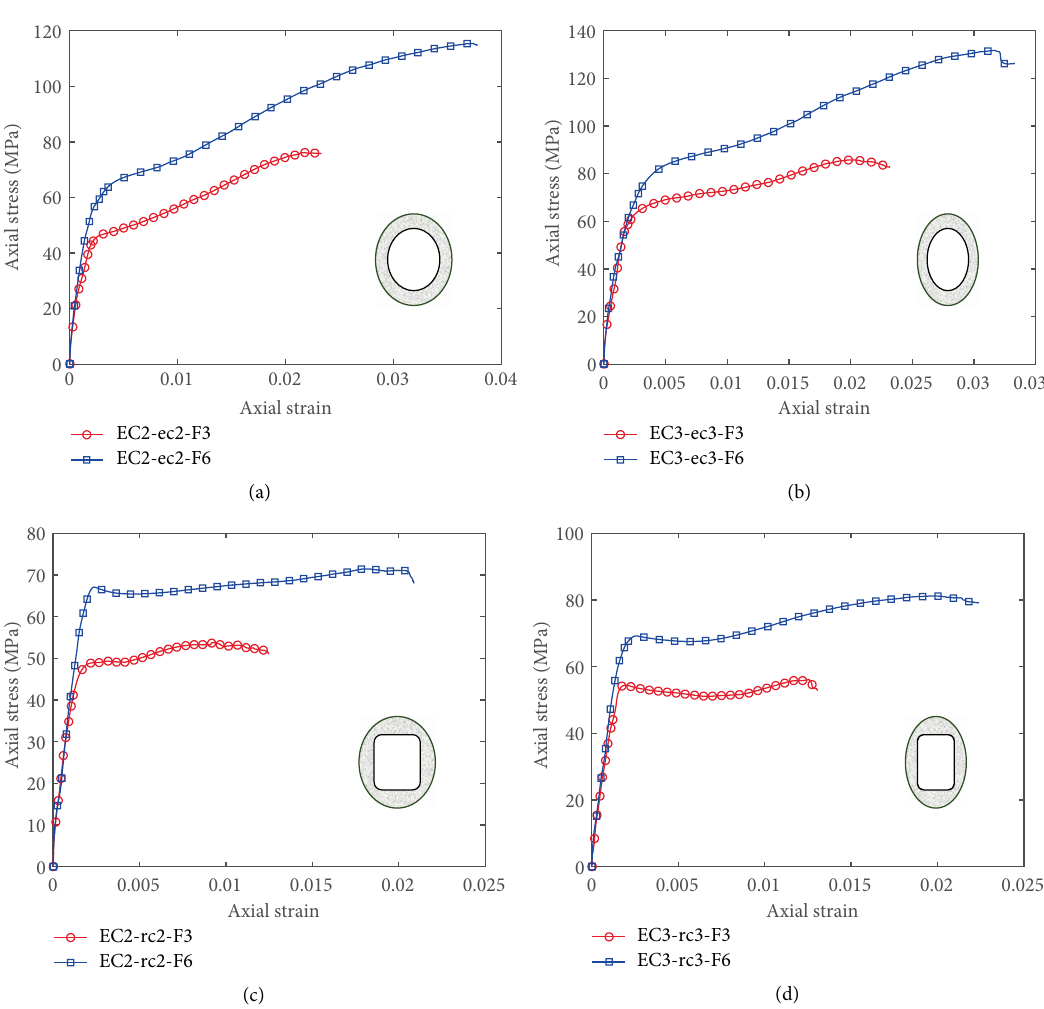
. (b) EE-DSTCs, 휌 𝐴 = 1.2